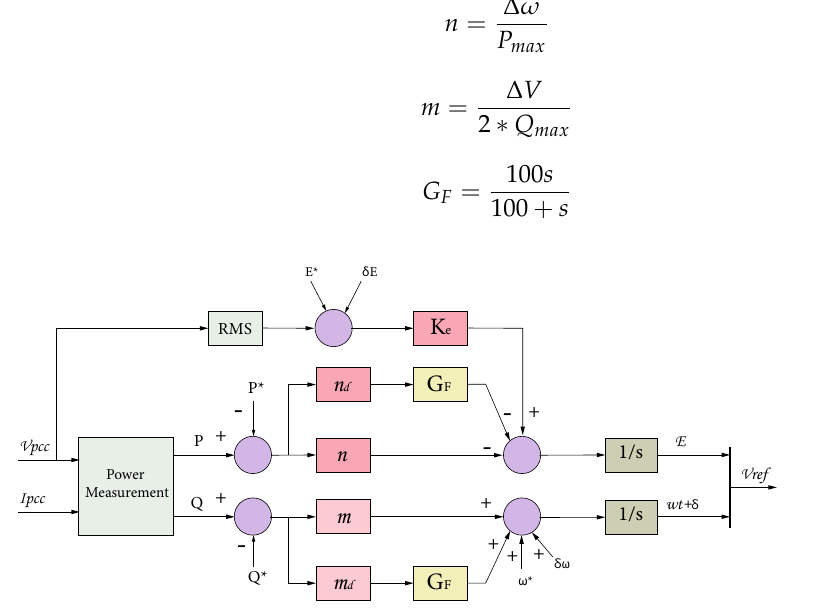
Figure 5. Block diagram for the secondary